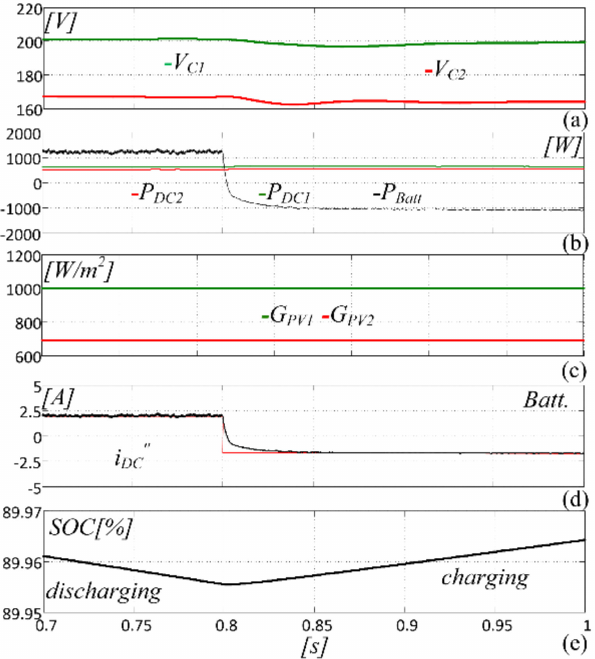
Figure 13. Si-level MMC-battery current transition from 2 A to − 2 A with G PV 1 (cid:54) = G PV 2 . ( a ) String voltages V c 1 and V c 2 . ( b ) Output power of PV1, PV2, and the battery. ( c ) Solar power G PV 1 and G PV 2 . ( d ) Battery current. ( e ) Battery SOC